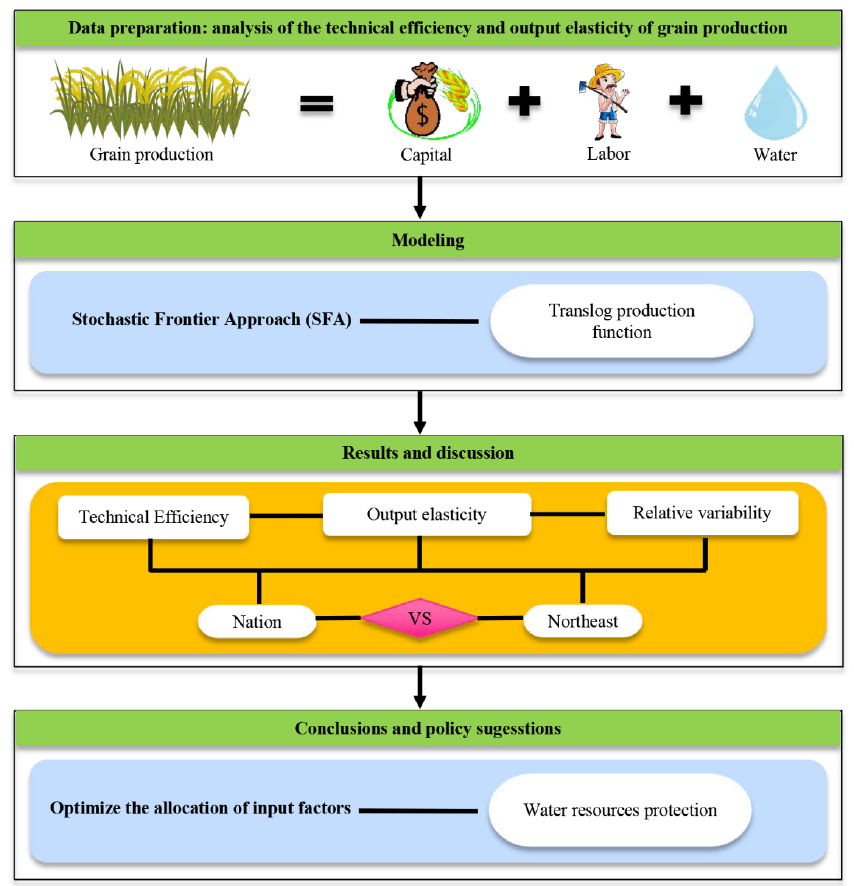
Figure 2. Methodological framework applied in the present analysis.